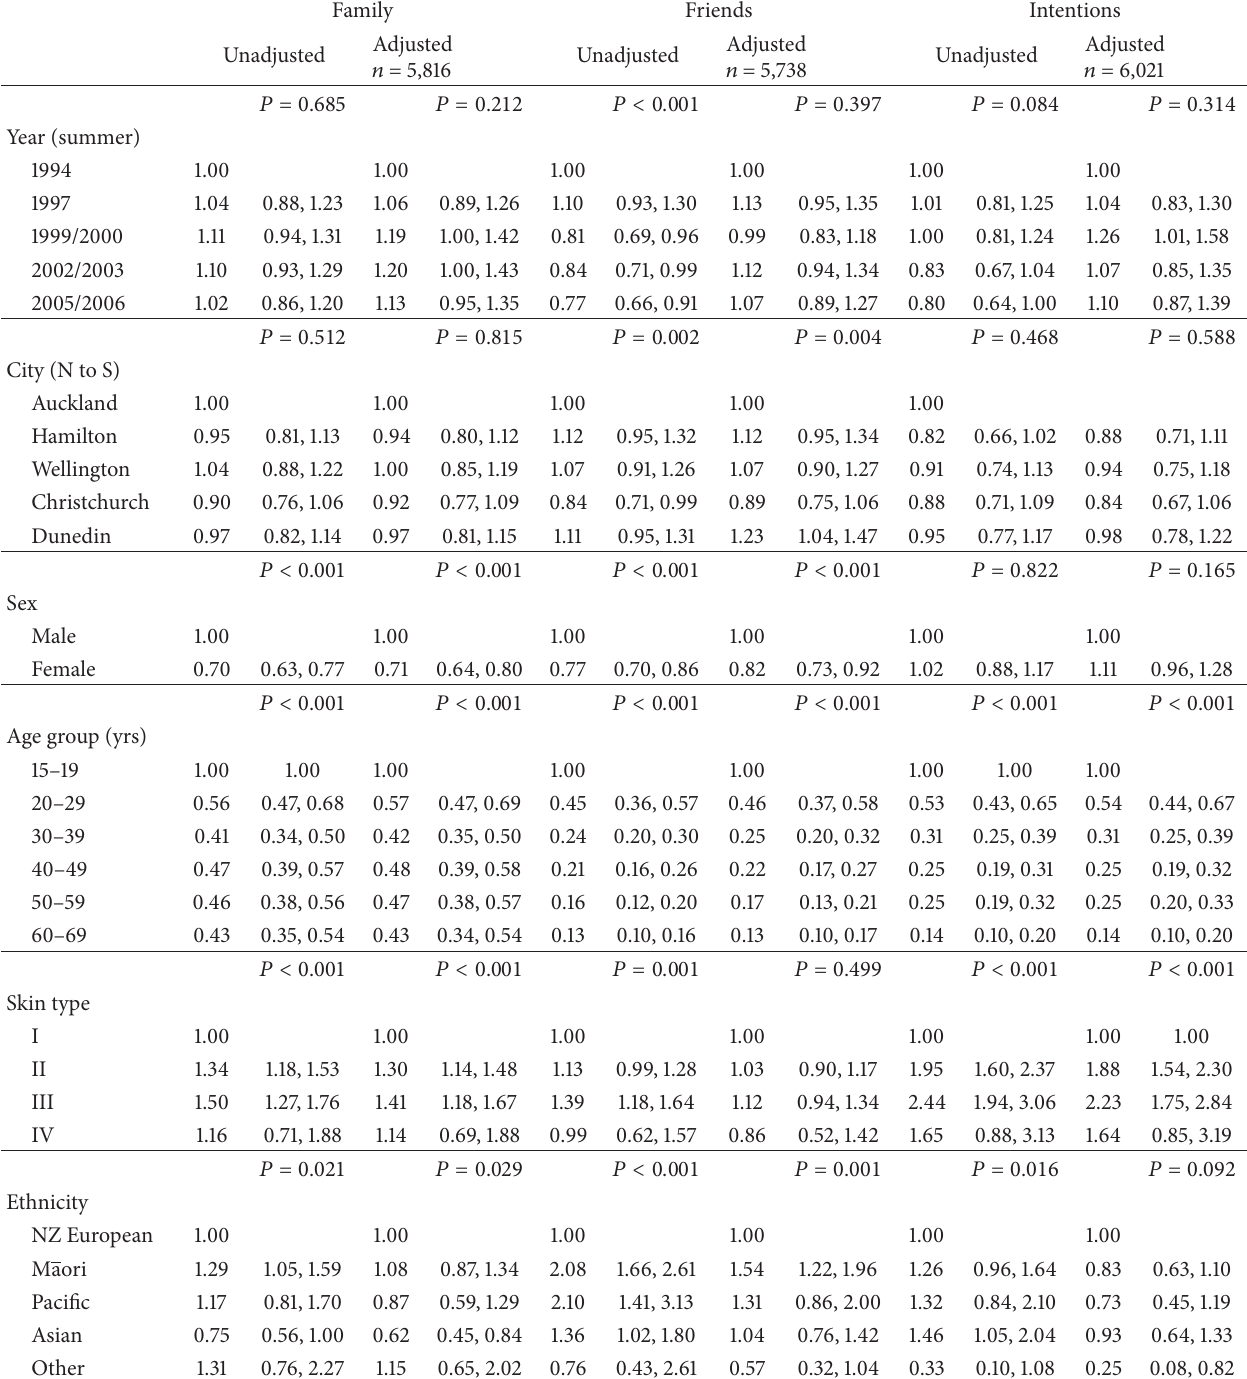
Table 3: Unadjusted and adjusted ∗ odds ratios and 95% confidence intervals for perceptions of others and intentions statements. Family Friends